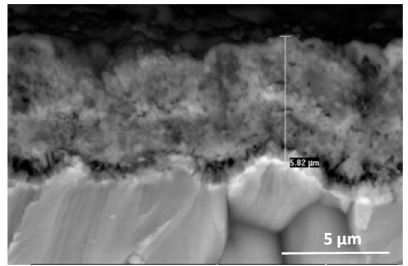
Figure 17. SEM-BSE images of Ti–46Al–7Nb–0.7Cr–0.1Si–0.2Ni alloy after cyclic oxidation at 975 °C (surface prepared by grinding).